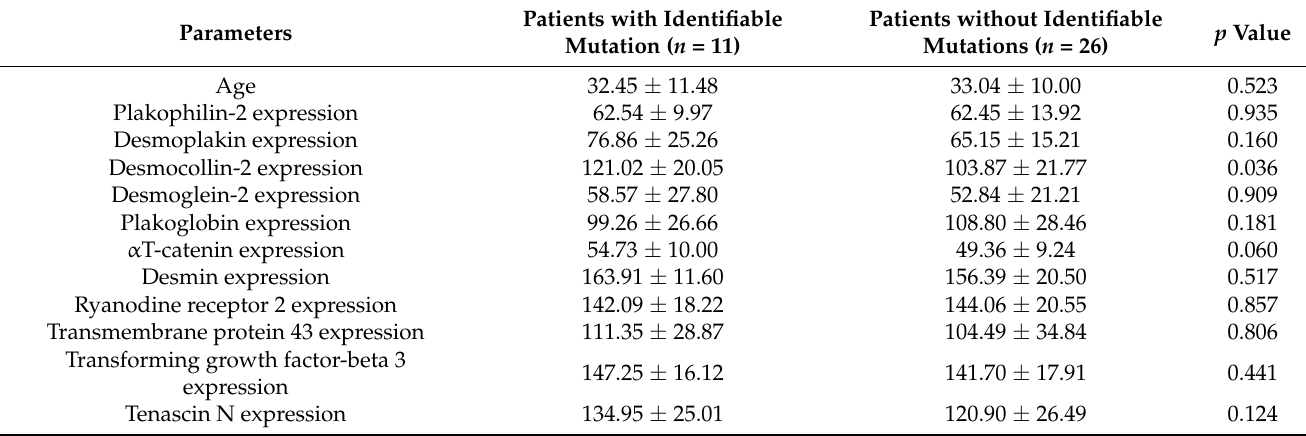
Table 2. Comparison of immunoreactivity between autopsied ARVC patients with and without identifiable gene mutations.